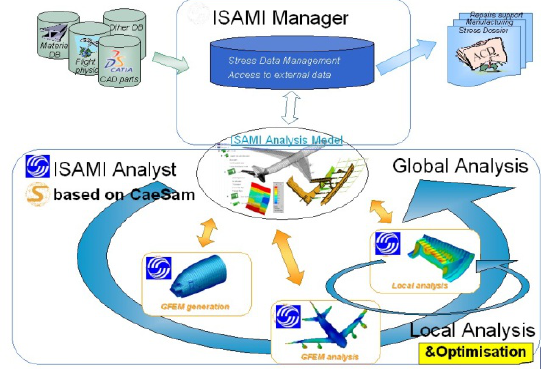
Fig. 10. ISAMI and optimization